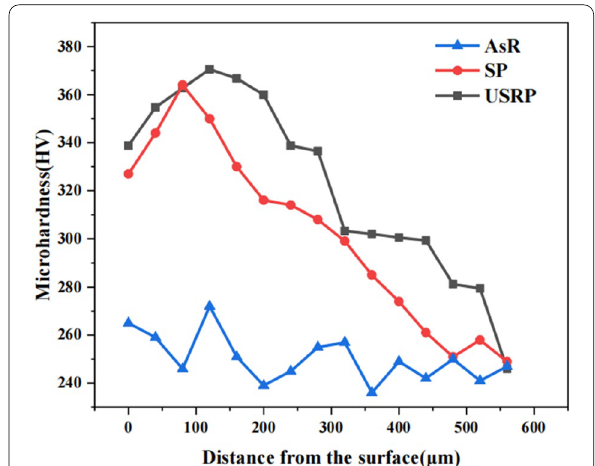
Figure 13 The Microhardness distribution of the AsR, SP and USRP specimens